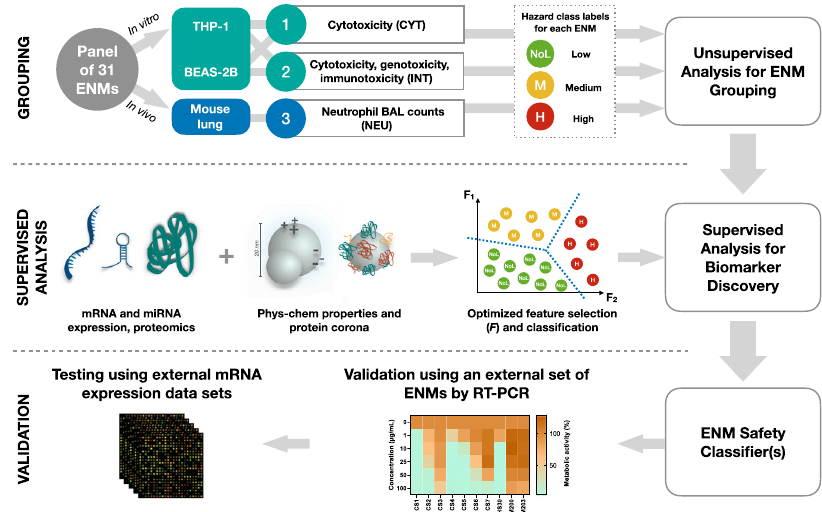
Fig. 1 The experimental and computational approach taken to develop the ENM safety classi fi er. The set of 31 ENMs comprises common nanomaterials with different core chemistries, sizes, shapes, and surface modi fi cations. THP-1 and BEAS-2B cells were exposed to a low-dose (EC10) of the ENMs alongside the in vivo exposures in mice. The panel of 31 ENMs were evaluated for their hazard based on cytotoxicity (CYT) and the combination of cytotoxicity, genotoxicity, and immunotoxicity (INT) in vitro as well as neutrophil (NEU) in vivo. Unsupervised learning techniques were then applied to group the ENMs based on the assessed toxicity endpoints. Next, feature selection and classi fi cation algorithms were used to identify subsets of molecular features (or biomarker models) and physicochemical properties that can distinguish ENMs with different hazard labels (NoL, Med, High). The identi fi ed biomarker models were validated by RT-PCR using an external panel of ENMs. Finally, RF-based classi fi ers that were trained on mRNA-based biomarker models were tested using publicly available mRNA expression pro fi les from various ENM